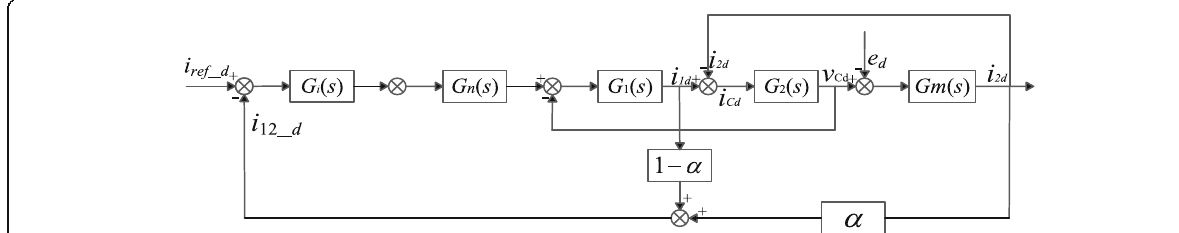
Fig. 5 Traditional weighted average current control block diagram under weak